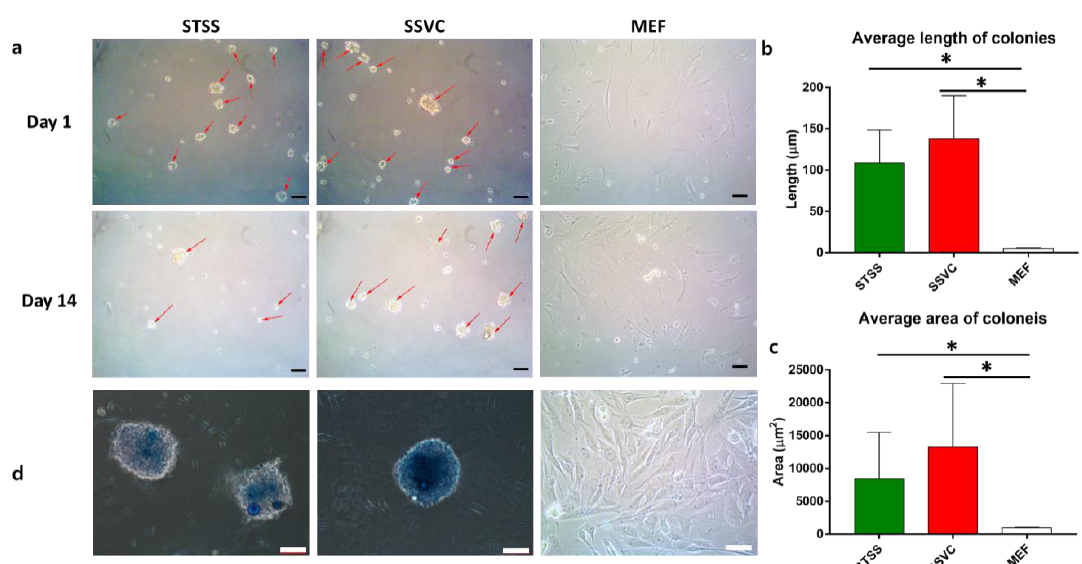
Figure 2. Comparative induction of MEF (mouse embryonic fibroblasts) into stem cell-like cells by STSS and SSVC methods in comparison to the control MEF. ( a ) Morphology of induced spheroids (scale bars = 200 µm). ( b ) Average area and ( c ) average length of spheroids show SSVC-generated spheroids to be significantly larger and longer than the STSS ones. (error bars represent standard deviation, * p < 0.05 was considered to be statistically significant, n = 3). ( d ) ALP (alkaline phosphatase) staining of spheroids after 14 days (scale bars = 100 µm).